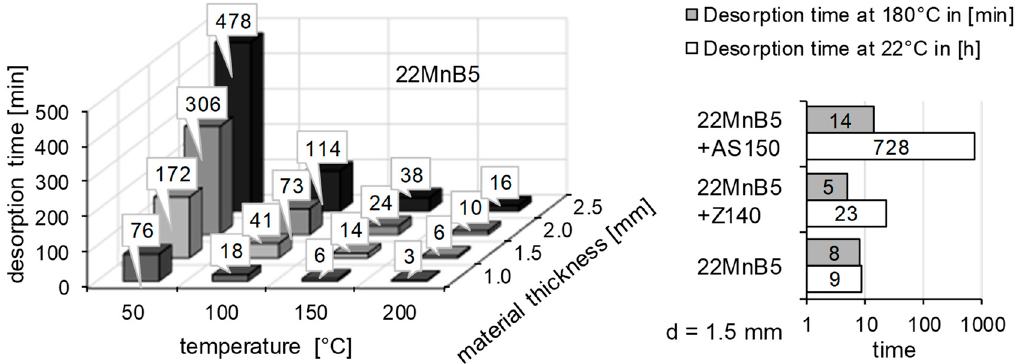
Figure 23. Calculated desorption times for the quenched and tempered steel 22MnB5 ( left ) and their coating concepts ( right ) under various conditions.